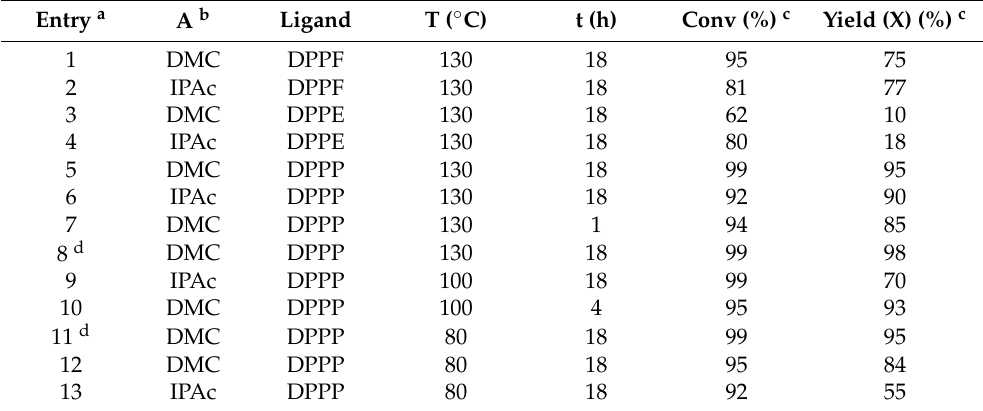
Table 3. Methoxycarbonylation of furfuryl alcohol ( IX ) in different reaction